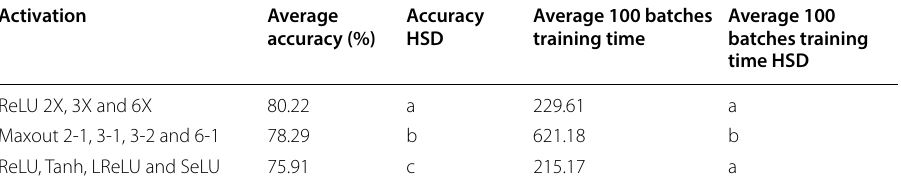
Table 15 HSD test on maxout, low memory usage activation functions and ReLU2x,